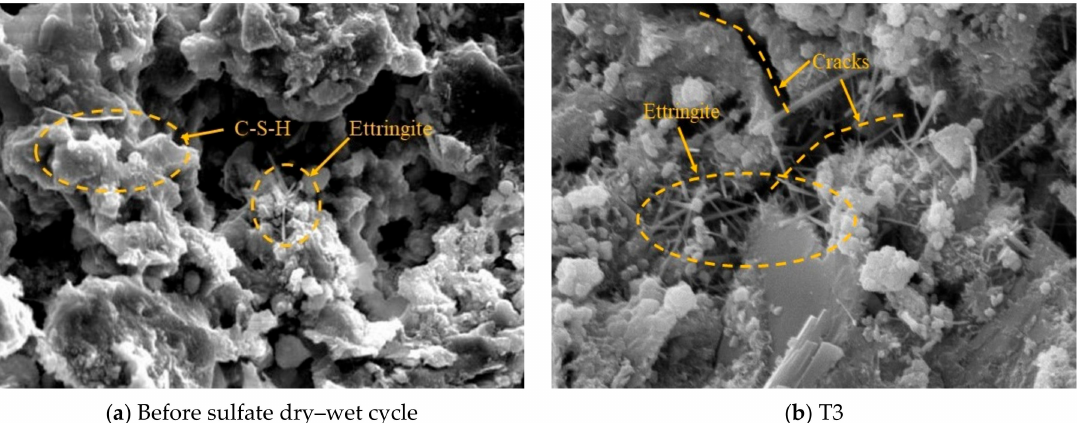
Figure 10. The microstructure before and after the sulfate dry–wet cycle for 84 days. ( a ) Before sulfate dry–wet cycle; ( b )